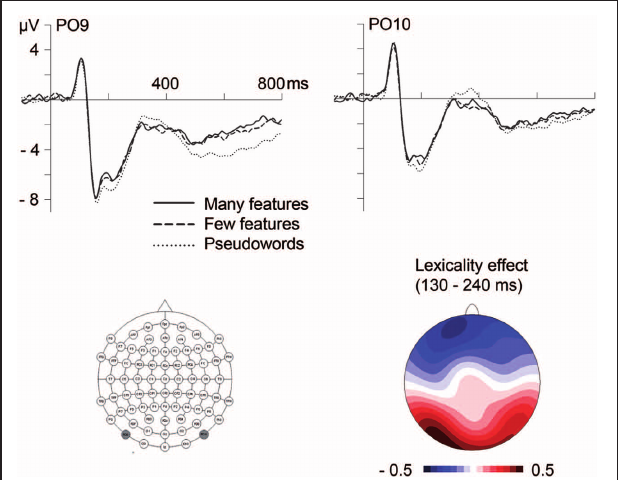
FIGURE 2 | Top. Influences of lexicality and the number of semantic features on event-related brain potentials at posterior electrode sites. Bottom . At left is a map of electrode locations with the depicted sites PO9 and PO10highlighted in dark gray. To the right is the topographical distribution of the lexicality effect (words minus pseudowords) between 130 and 240ms.